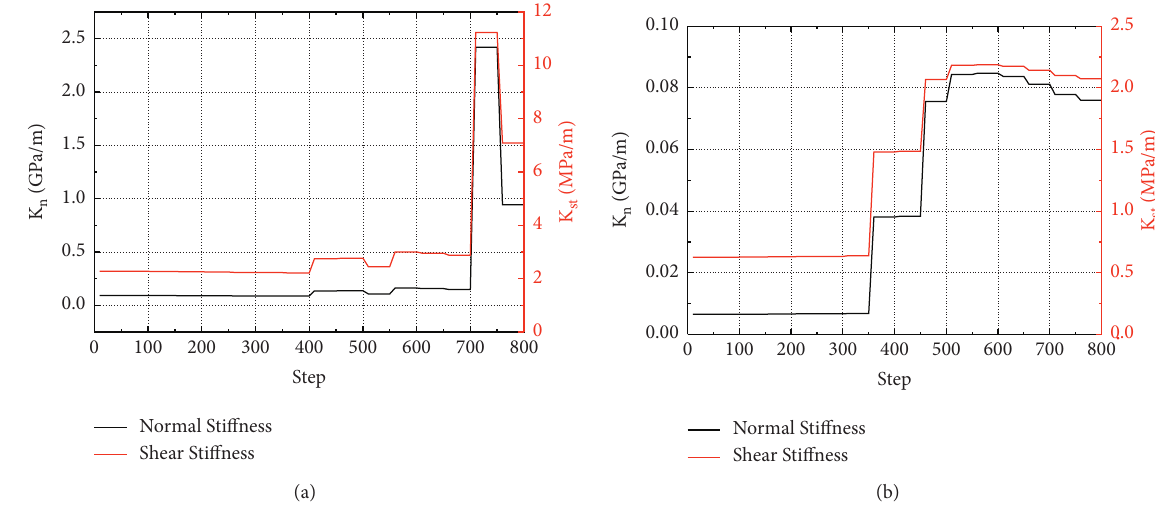
Figure 9: The monitoring curves of structural strength. (a) Near-horizontal joint. (b) Near-vertical joint.